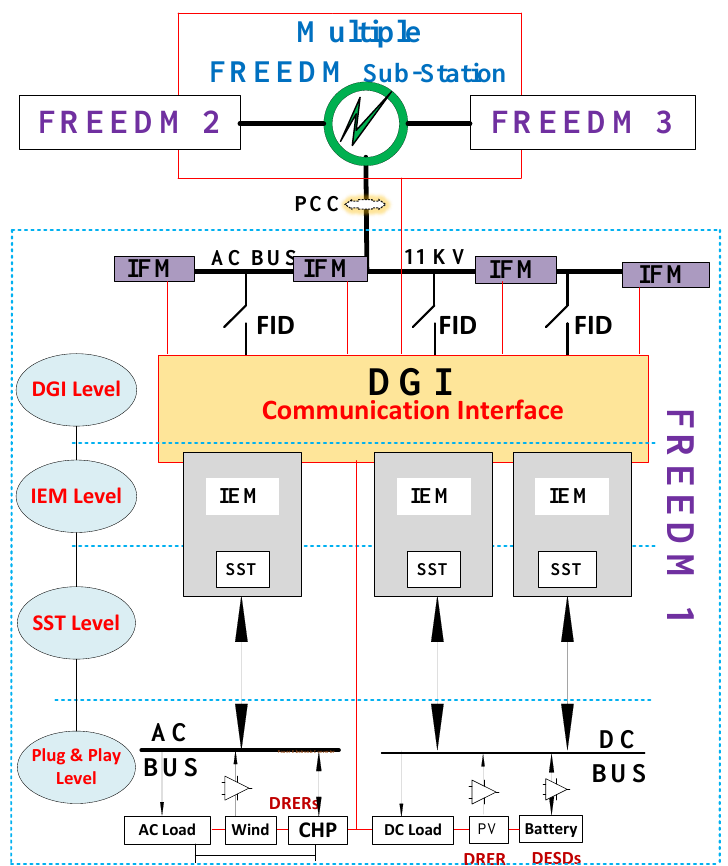
Figure 2. Levels of operation in Future Renewable Electric Energy Delivery and Management (FREEDM) design in the energy internet (EI) .